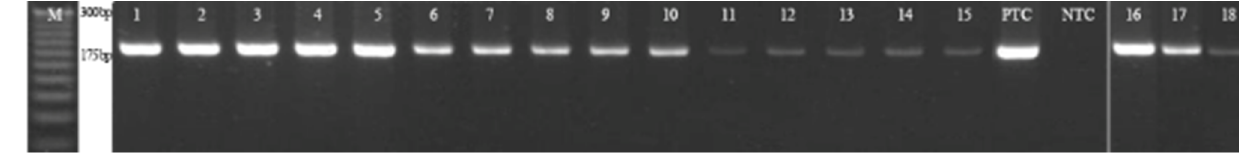
Figure 3. PCR result for the analyzed primers F3/R3. Results of the PCR reaction for the third primer pair. Lanes 1, 6, and 11—DNA of Rouen duck (French selection); lanes 16–18—DNA of Rouen duck (English selection); lanes 2, 7, and 12— DNA of KhO-1; lanes 3, 8, and 13—mix of Pekin duck DNA; lanes 4, 9, and 14—DNA of Dworka duck; and lanes 5, 10,